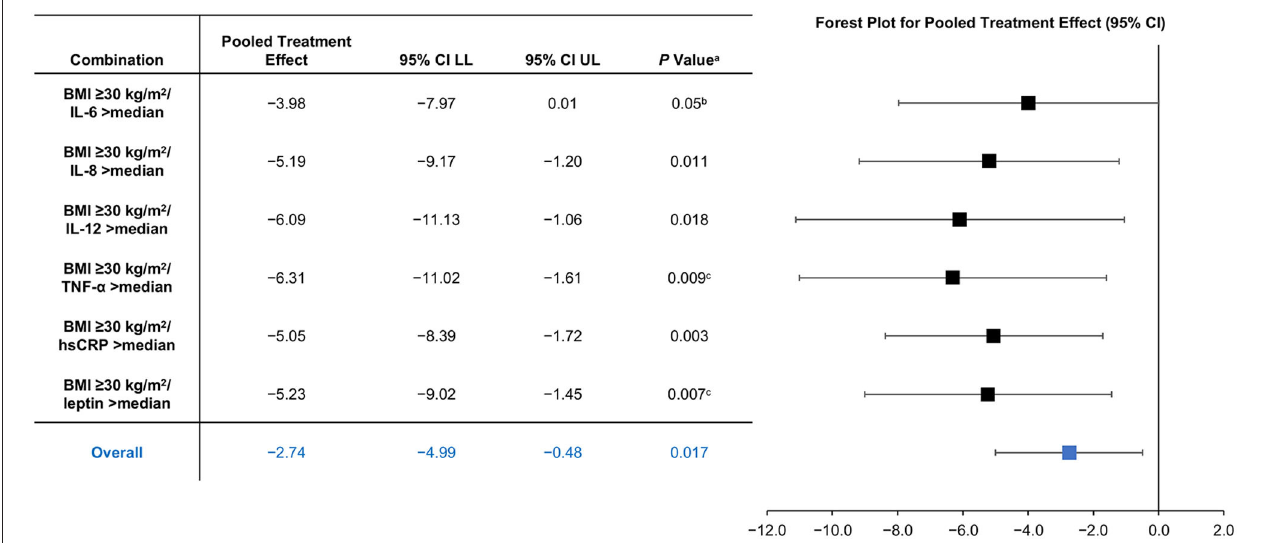
FIGURE 1 | Synergistic Effects for L-Methylfolate Minus Placebo by Combination of Obesity and Inflammatory Biomarkers (22). a P -value from χ 2 test from seemingly unrelated regression. b Not significant after multiple correction. c P < 0.03 after correction for multiple testing for a priori hypothesis. BMI, body mass index; CI, confidence interval; hsCRP, high-sensitivity C-reactive protein; IL, interleukin; LL, lower limit; TNF- α , tumor necrosis factor alpha; UL, upper limit.